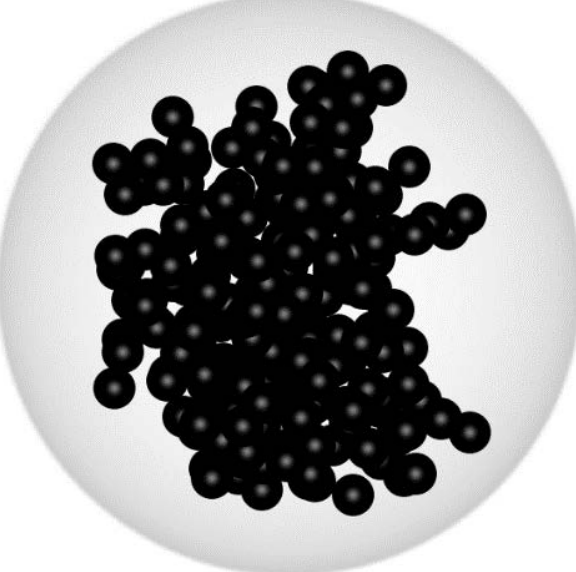
Figure 1. Sketch map of the geometry of coated black carbon. An example of fractal black carbon aggregates, containing 200 monomers, is coated by